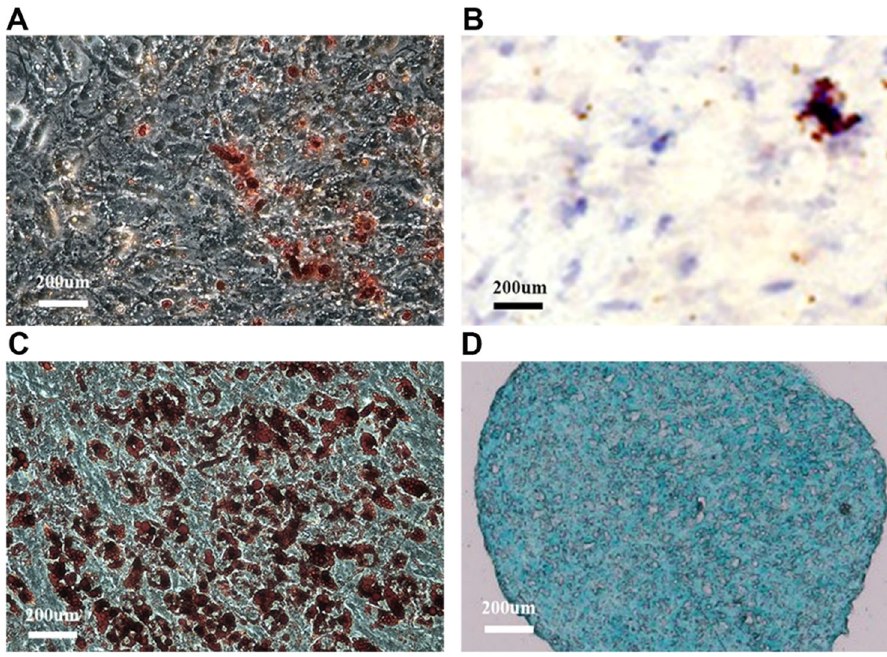
Fig. 2 Differentiation analysis